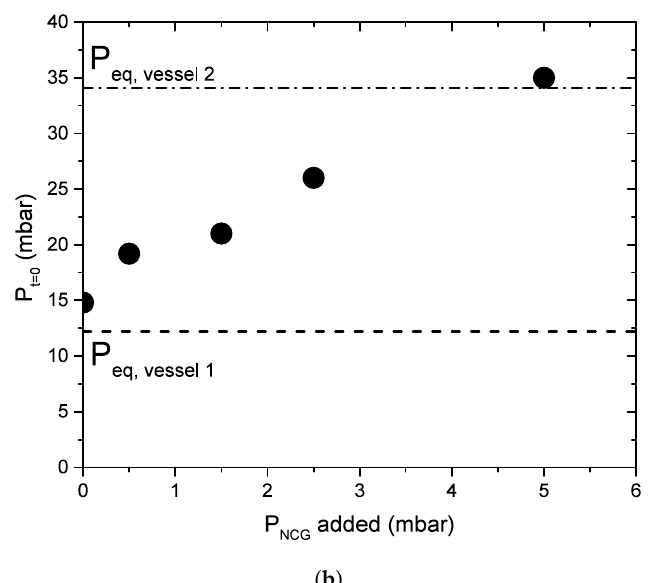
Figure 9. ( a ) Pressure in setup during mass transport from vessel 2 into 1. ( b ) The pressure measured in the setup directly after opening the valve between vessel 1 and 2. The dot-dashed line is the equilibrium pressure of vessel 1 and the dashed line is the equilibrium pressure of vessel